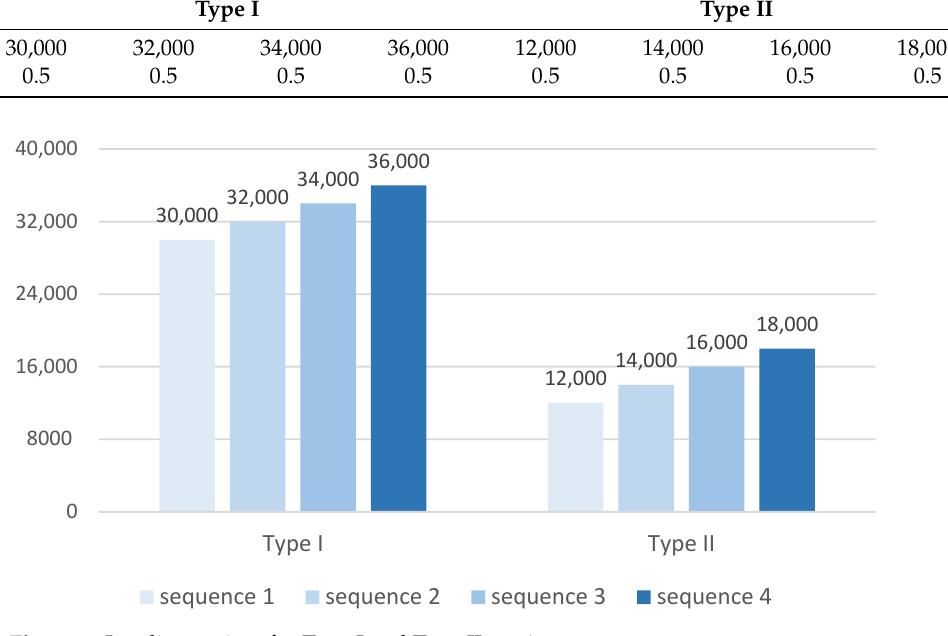
Figure 2. Loading regime for Type I and Type II gratings.